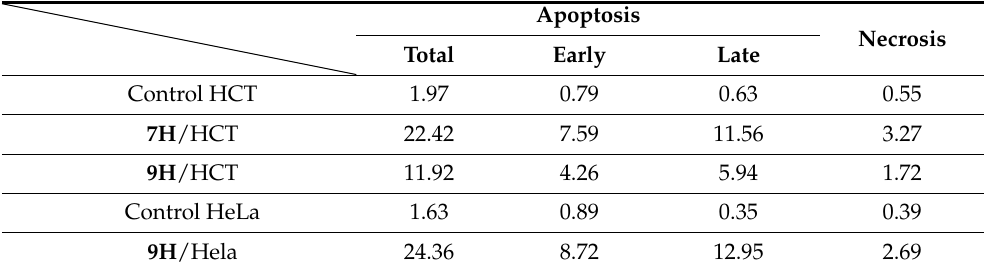
Table 10. The apoptosis and necrosis pattern in the control and treated cancer cells treated with 7H and 9H